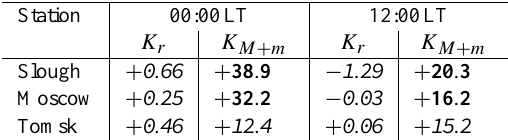
Table 5. Same as Table 4, but for the period of decreasing geomagnetic activity